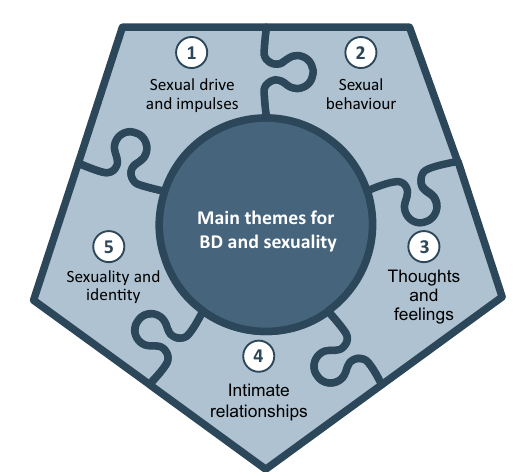
Fig. 1 Main themes on BD and